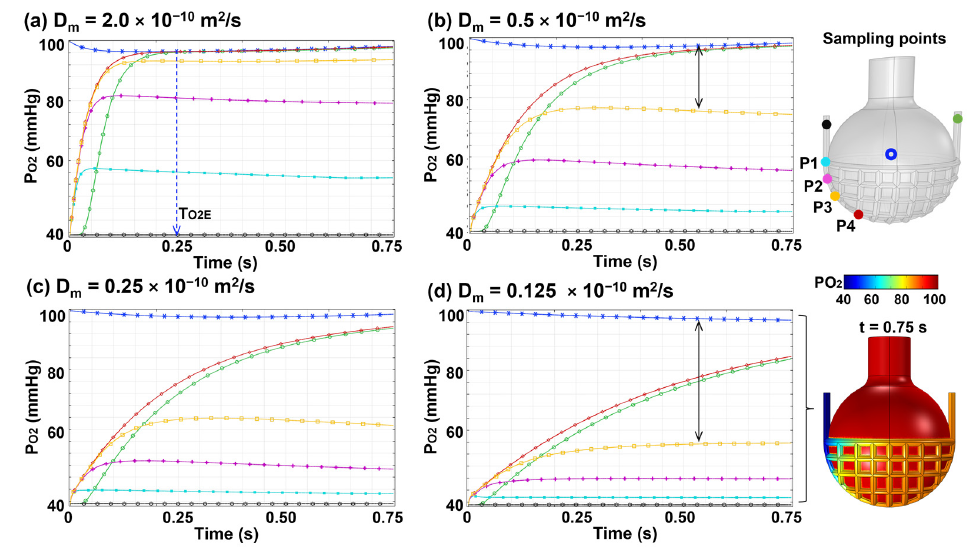
Figure 9. Effects of the membrane diffusivity (D m ) on the temporal and spatial distribution of PO 2 : ( a ) D m = 2.0 × 10 − 10 m 2 /s, ( b ) D m = 0.5 × 10 − 10 m 2 /s, ( c ) D m = 0.25 × 10 − 10 m 2 /s, and ( d ) D m = 0.125 × 10 − 10 m 2 /s.